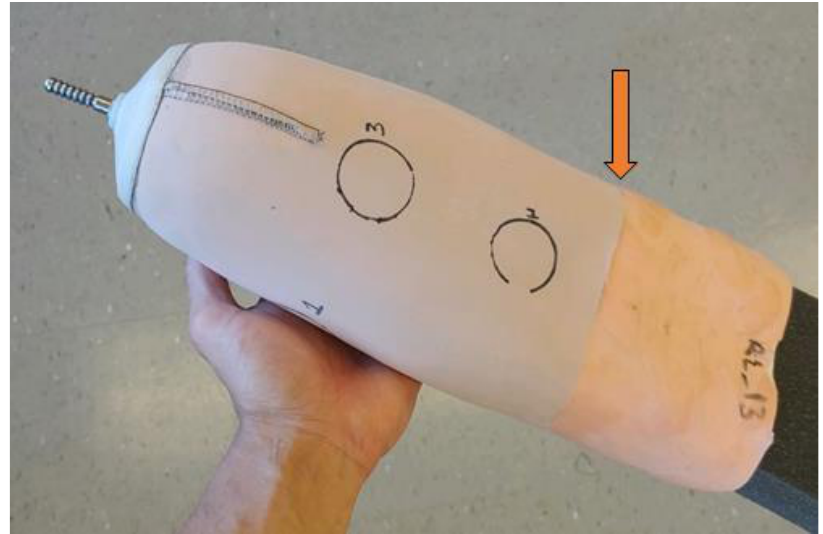
Figure 4. Completed elastomeric liner with an embedded ferrous polymer target. The arrow indicates the proximal edge of the e-FPPC. The circles indicate locations of sensor antennae when the liner is within the user’s socket.